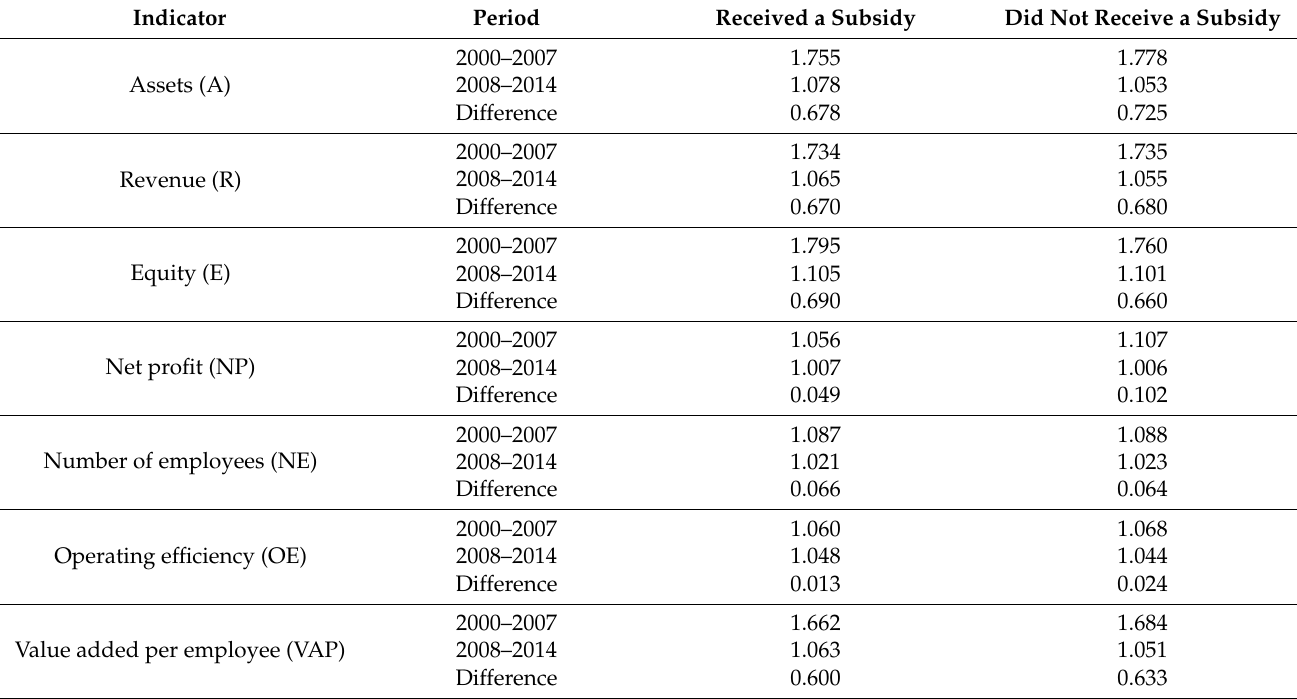
Table 5. Differences in mean values of the economic and financial indicators indices in the two financial periods for enterprises that did and did not receive